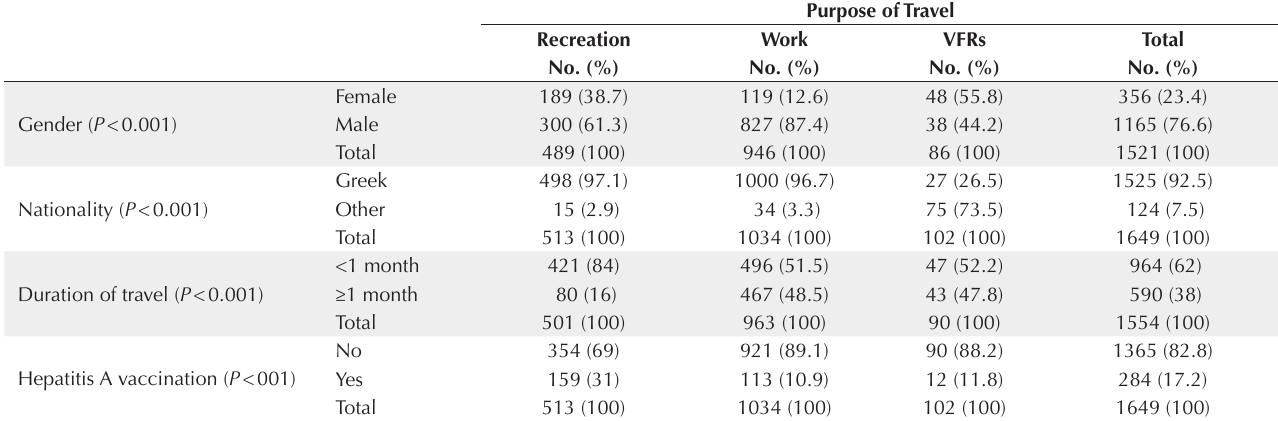
Table 4. Purpose of Travel According to Gender, Nationality and Duration of Travel a